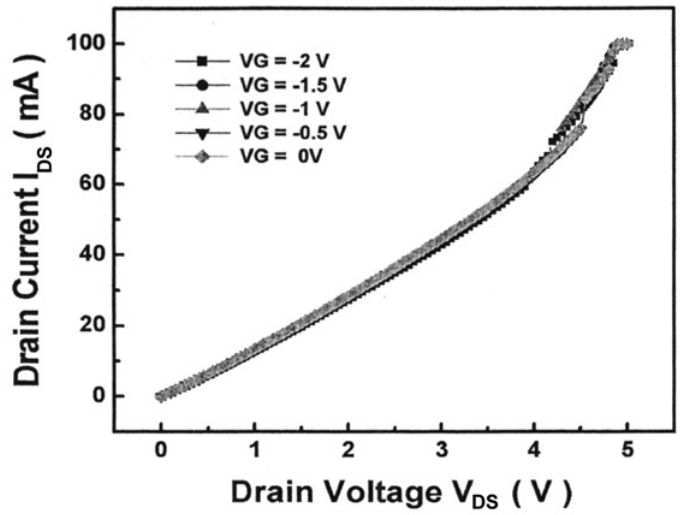
FIGURE 12 The I ds – V ds characteristic of InAlAs = InGaAs